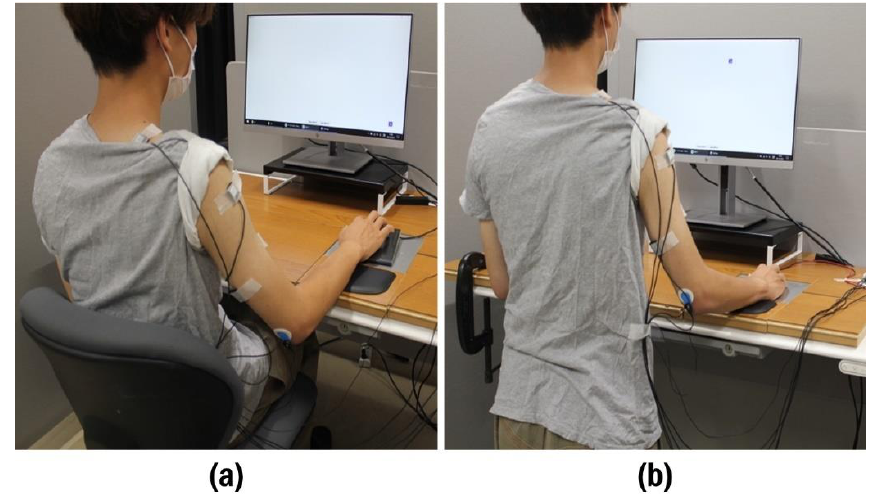
Figure 1. Experimental setups of ( a ) sitting and ( b ) standing workstations. The top of the desk was covered with a plywood board (thickness:2 cm); on the right side of the desk, a pointing device was placed according to the conditions and used by the participants throughout the trials. This study involved three different pointing devices: a conventional mouse (M280B, Logicool, Tokyo, Japan) (Figure 2a), a vertical mouse (MX Vertical ergonomic mouse, Logitech) (Figure 2b), and a trackball (SlimBlade Trackball 72327JP, Kensington, Redwood City, CA, USA) (Figure 2c). A force-sensitive resistor (FSR-400; Interlink Electronics Inc., Camarillo, CA, USA) was secured on the left button of the pointing device to record activation timing offline. Under the range of pointing device movement, a force plate, with three loadcells (MCSR-5L-FG, Toyo Sokki Co., Ltd., Kanagawa, Japan), arranged into a triangular layout secured to the bottom of an aluminum plate (200 mm × 200 mm × 5 mm), was mounted flush with the plywood board (Figure